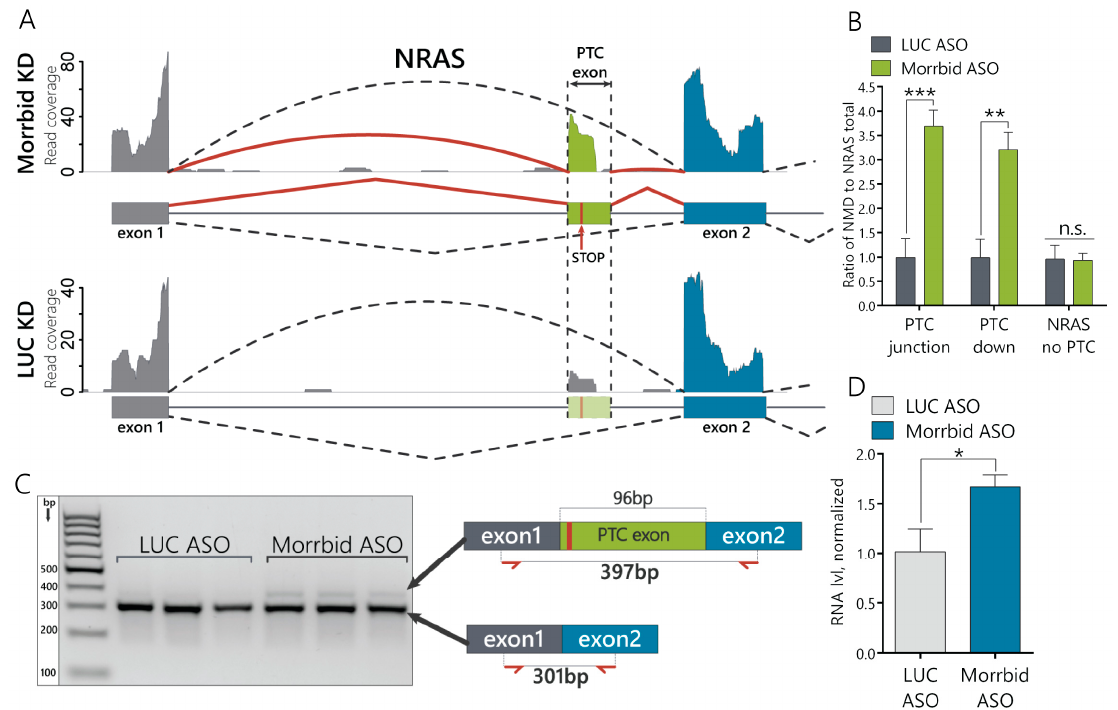
Figure 2. Morrbid lncRNA depletion leads to the enhanced incorporation of the NRAS premature termination codons (PTC) exon in murine hepatocytes. ( A ) RNA coverage of the zoomed region of the NRAS transcript in Morrbid and LUC control knockdowns. The solid and dashed arced lines represent the RNA coverage of the splice junctions. ( B ) RT-qPCR analysis of the NRAS isoform expression after Morrbid KD and control LUC KD using primers laying on the junction between the PTC exon and neighboring exons (PTC junction) and spanning across the junction to the downstream neighboring exon (PTC down). ( C ) Image of amplicon separation by agarose gel electrophoresis. Amplicons were obtained with primers spanning across the alternative NRAS exon to amplify the PTC and no PTC NRAS transcripts. ( D ) RT-qPCR analysis of the NRAS pre-mRNA level in the control LUC and Morrbid KD cells using primers that amplify the fragment with exon 1 and intron. NMD: nonsense-mediated decay. Results show mean ± SD. n.s.—not significant. * p < 0.05, ** p < 0.01 and *** p <